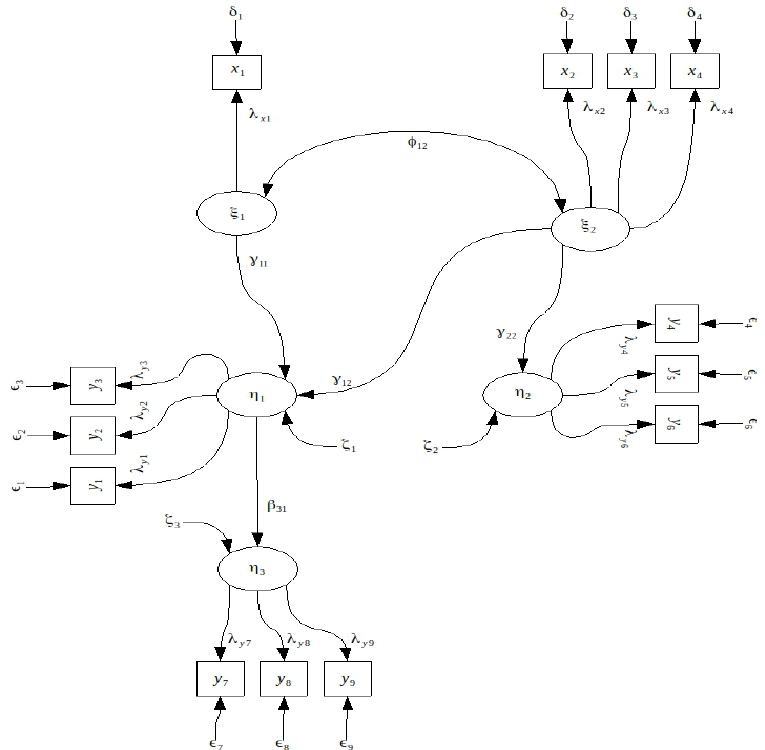
Figure 2. Diagram of the structural